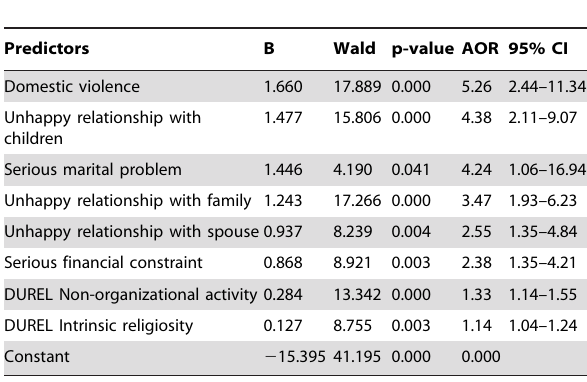
Table 9. Predictors of depression after removing anxiety, stress and